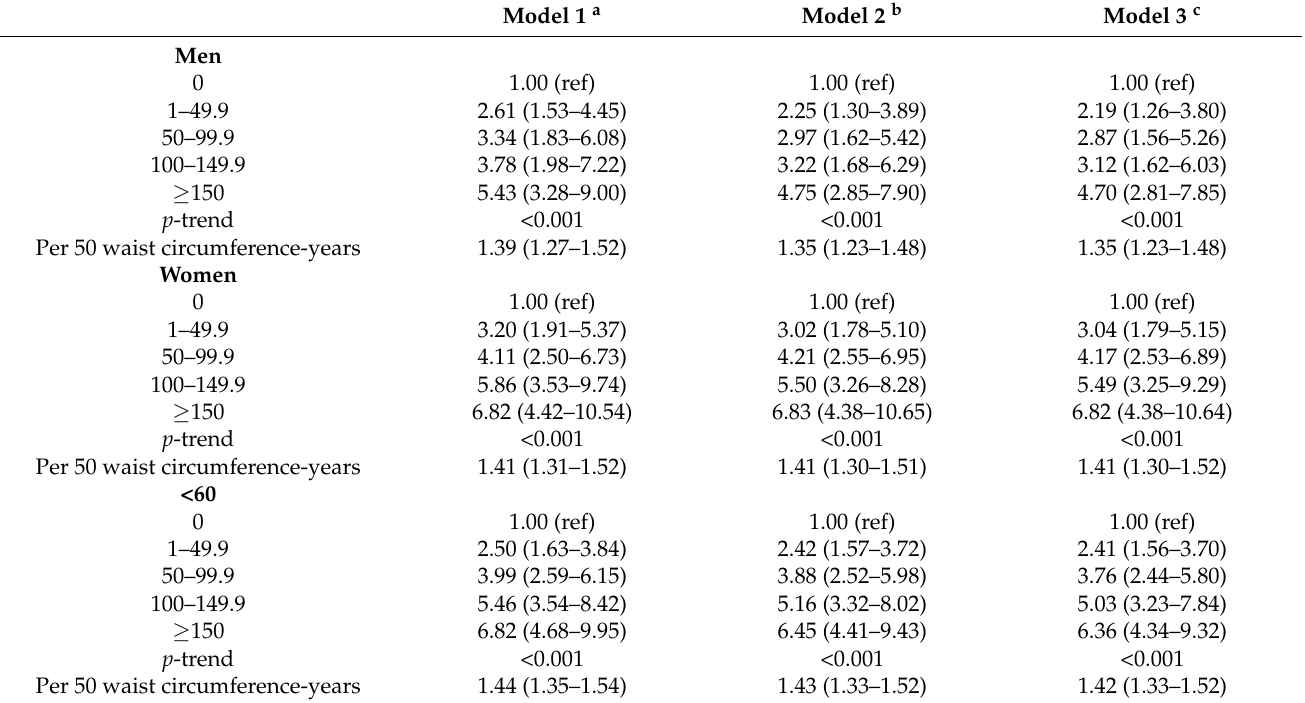
Table 3. The odds ratio and 95% confidence interval for type 2 diabetes according to waist circumference-years